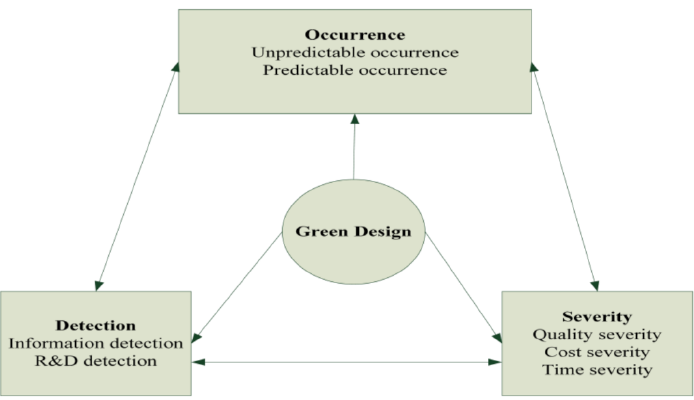
Figure 3. The ANP plot of green design.